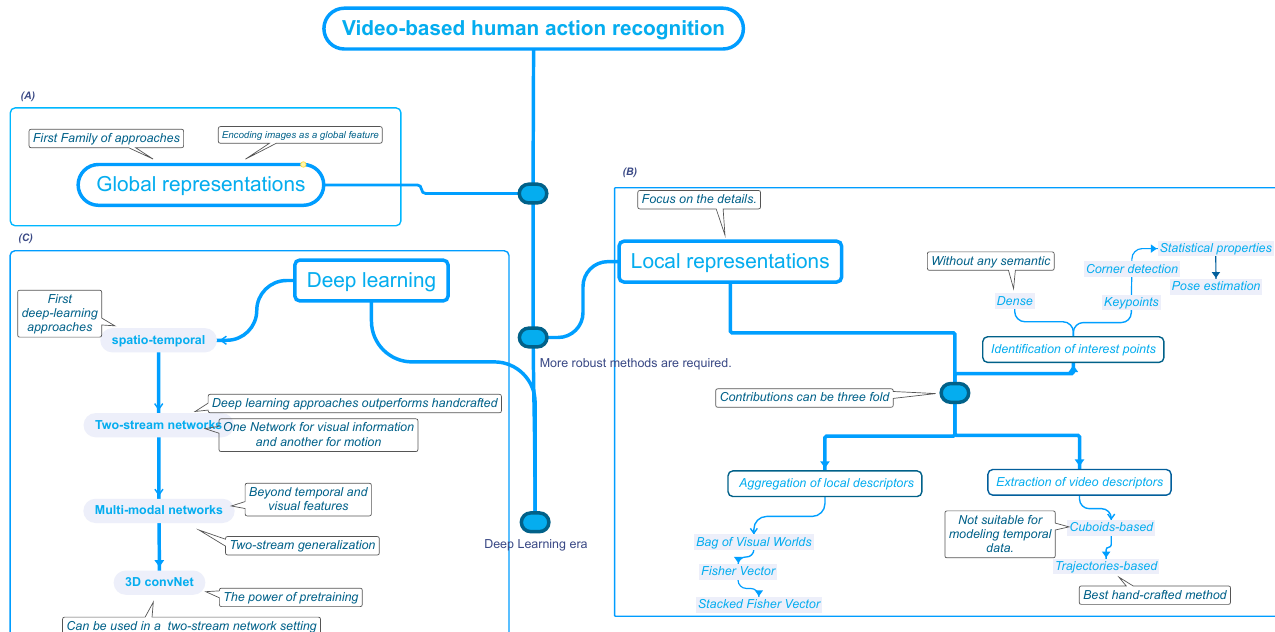
Figure 2. The Evolution of Action Recognition Approaches. The initial attempt at vision-based human action recognition relied on global representations ( A ), which were inferior to local representations ( B ). Lastly, deep learning approaches ( C ) became the most popular, with 3D convolutional neural networks becoming the most advanced because they can learn multiple levels of